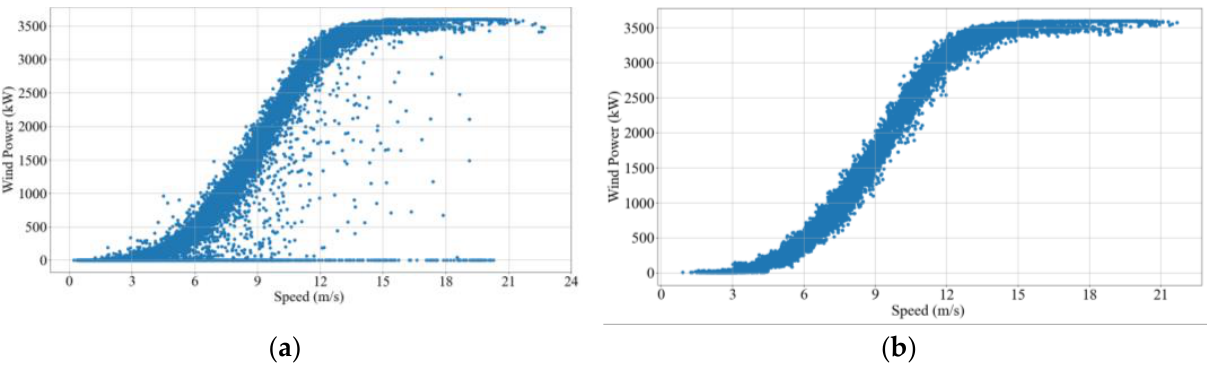
Figure 8. Curves for wind power data: ( a ) before pre-processing and ( b ) after pre-processing.